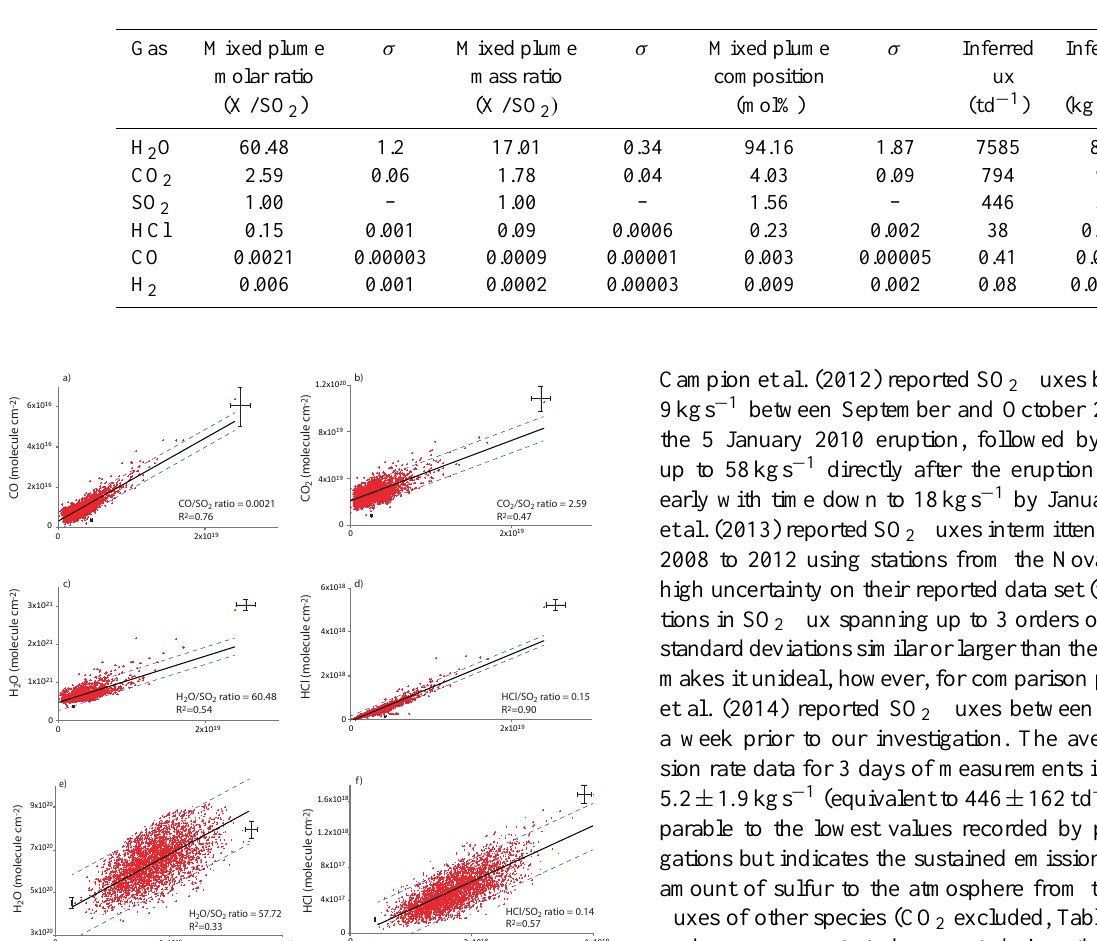
Table 2. X/SO 2 molar and mass ratios measured by FTIR spectroscopy and multi-gas (for H 2 ) and gas composition of the mixed plume. The inferred flux range of each species is based on an SO 2 flux estimate of 210.7td − 1 . Errors are expressed as the standard error of the regression analysis and subsequent propagation.